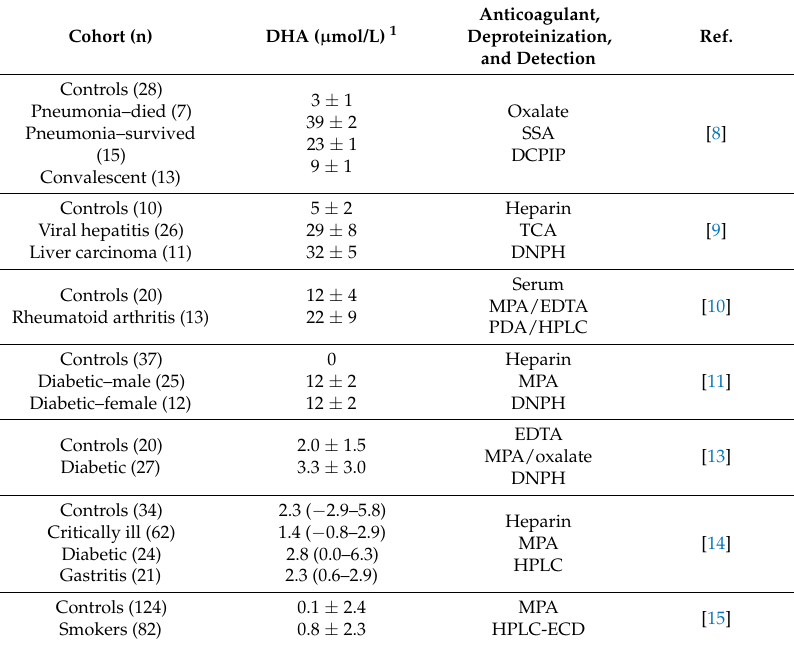
Table 3. DHA concentrations in published clinical studies.